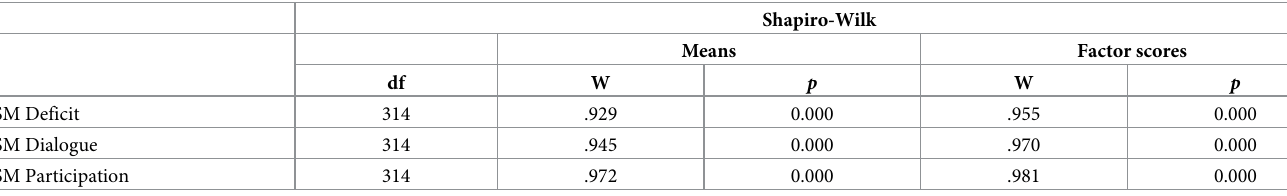
Table 6. Shapiro-Wilk tests—Social media science communication